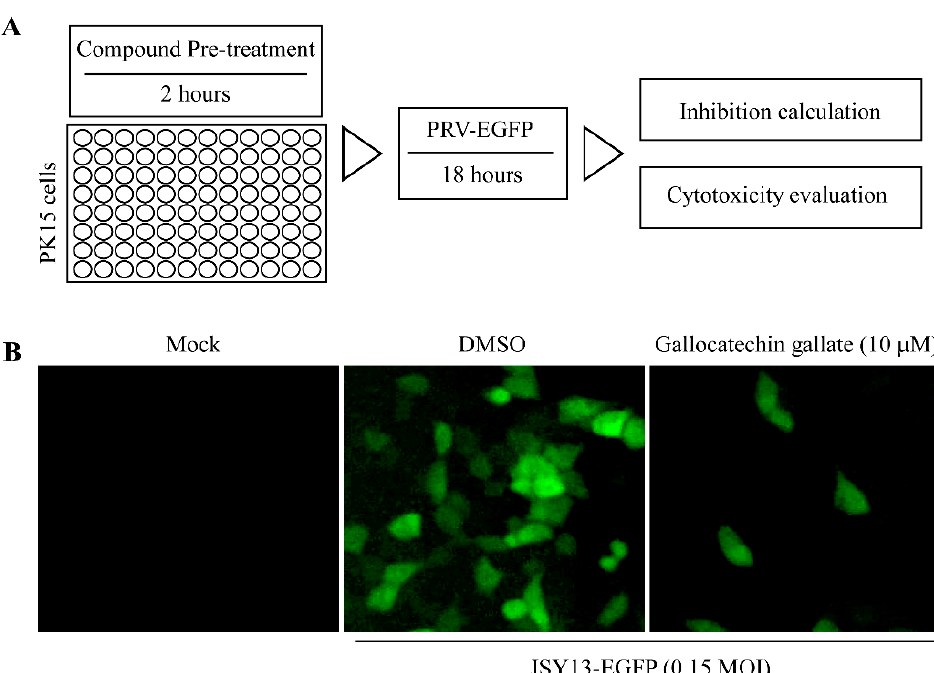
Figure 1. Gallocatechin gallate efficiently inhibited the replication of PRV. ( A ) Schematic of the processes in the screening of anti-PRV compounds. The cells in 96-well plates were pretreated with different kinds of compounds (10 µ M) for 2 h. The cells were then infected with JSY13-EGFP (0.15 MOI), and 18 h later, the fluorescence intensity of each well was evaluated. ( B ) Gallocatechin gallate inhibits the replication of PRV. The experiment was performed as introduced in ( A ), and the fluorescence figure in gallocatechin gallate-treated cells was